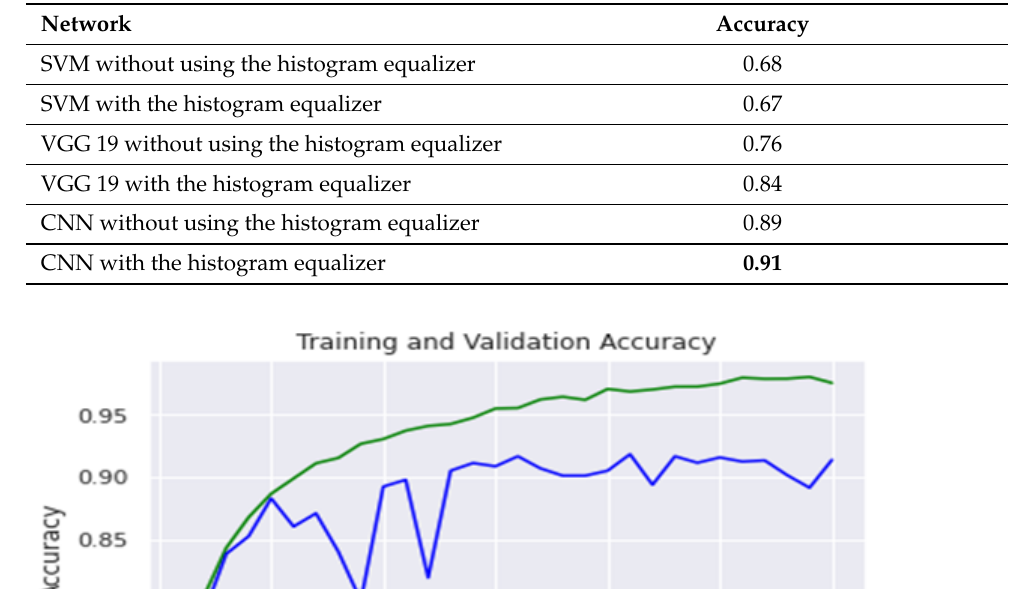
Table 6. Summary of results accuracy classification.